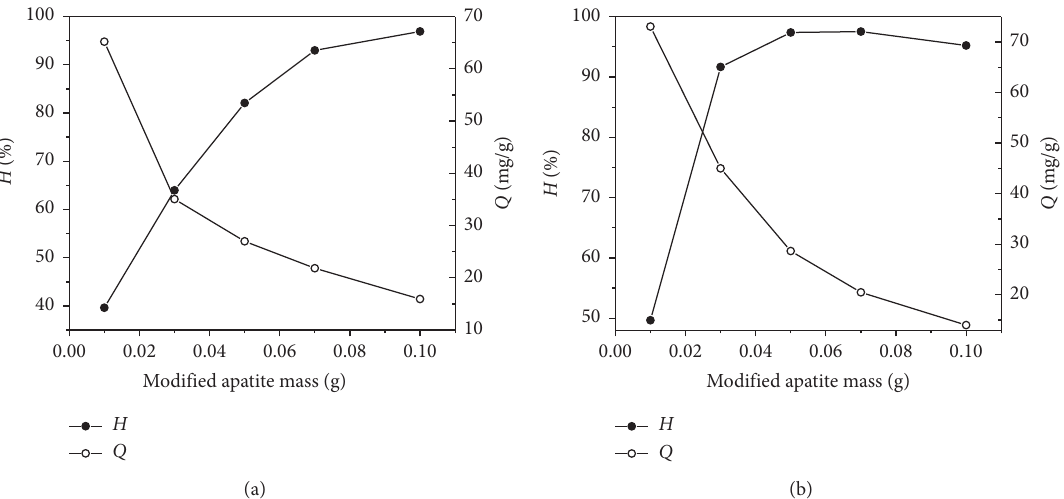
Figure 7: Variation of the Cd 2+ /Cu 2+ adsorption capacity and efficiency according to the modified apatite ore mass at pH t � 60 mins. (a) Cd 2+ , (b) Cu 2+